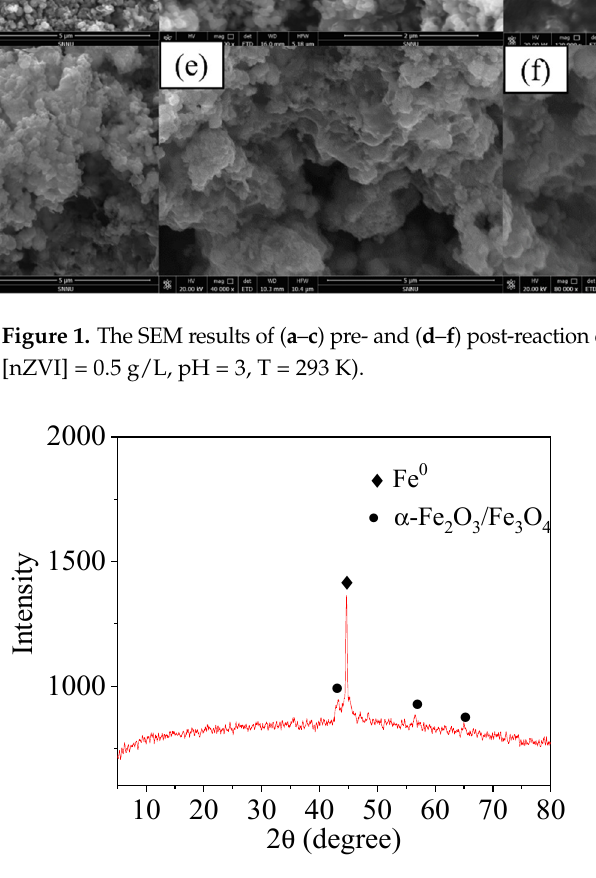
pH = 11.0 Figure 3. ( a ) Removal of Cr(VI) by nZVI as a function of time at different initial pH. ( b ) The change of solution pH with reaction time. ([Cr(VI)] = 25 mg/L, [nZVI] = 0.5 g/L, T = 293 K).